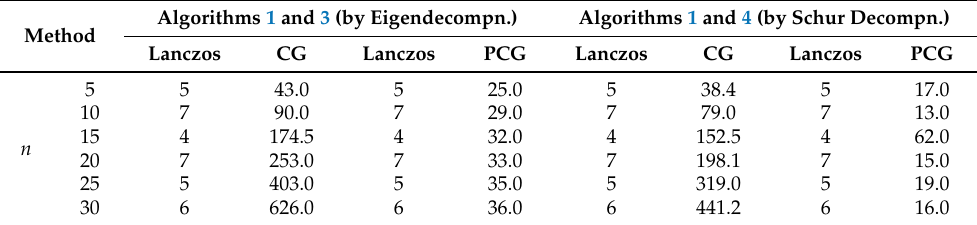
Table A3. Number of iterations of the Lanczos method and the average of numbers of iterations of the CG/PCG method in the case of the 5-th max. singular value of marginally symmetric matrix T with a = c = 1 and b = 0.2 in (9) for the shift (A1). Algorithms 1 and 3 (by Eigendecompn.) Method